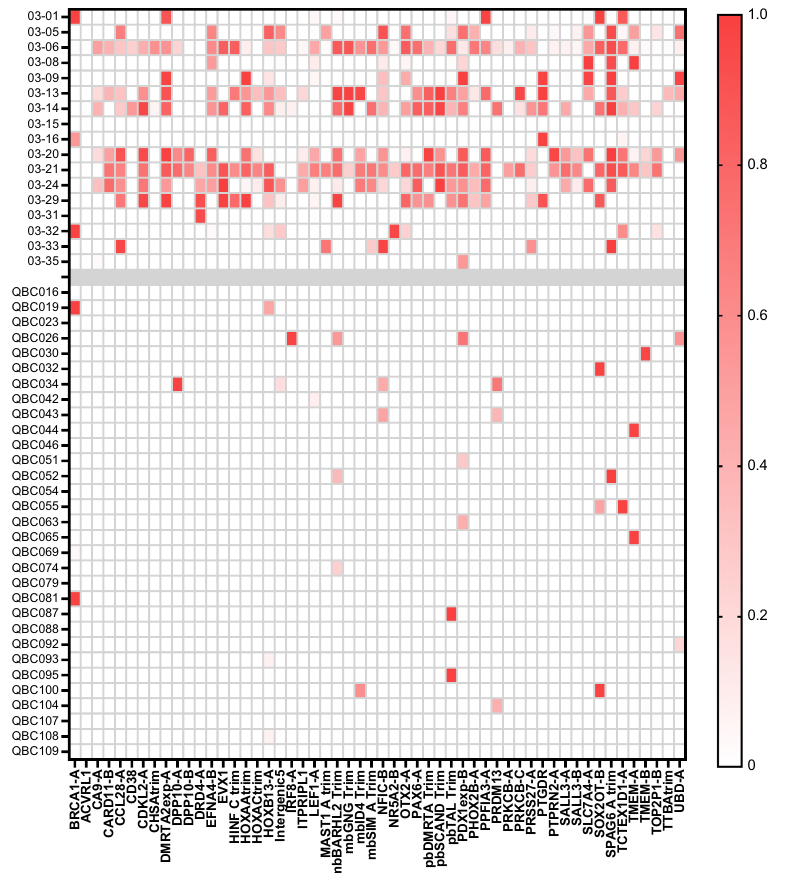
Fig. 7 mDETECT analysis of Validation Cohort 03 samples and new control plasma DNA. The DNA from 17 patients not included in the Test Cohort, as well as 31 new plasma samples from healthy age-matched volunteers (QBC 16-109) were analysed using mDETECT for the 54 optimal probes as described in Fig. 6. A heatmap of the fraction of methylated DNA for each probe is shown as described in Fig.